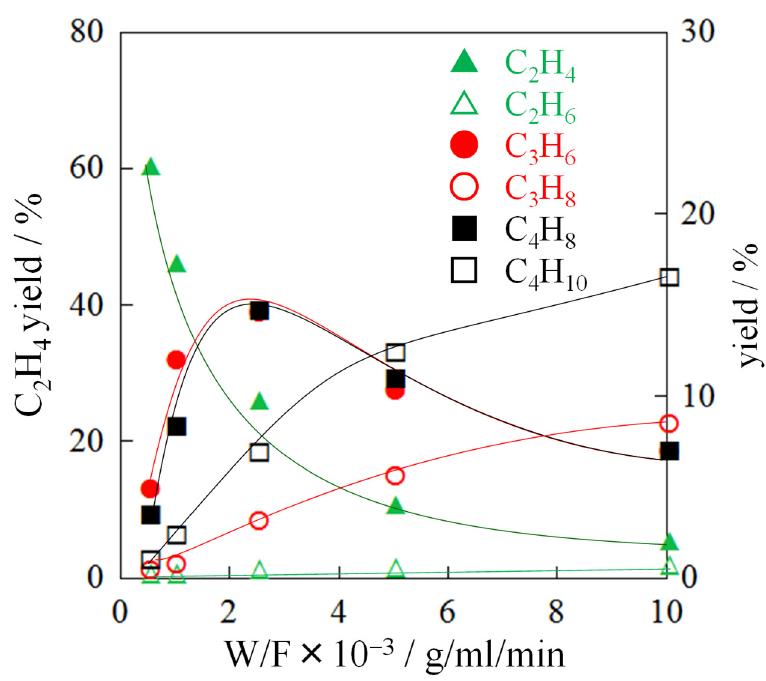
Figure 9. Product distributions of ETO reactions on H-ZSM-5(80) catalyst. Temperature, 400 °C; EtOH concentration, 50%.